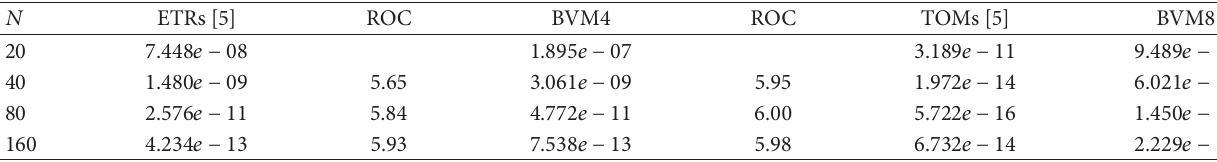
Table 3: Maximum Errors for different stepsizes for Example 2.